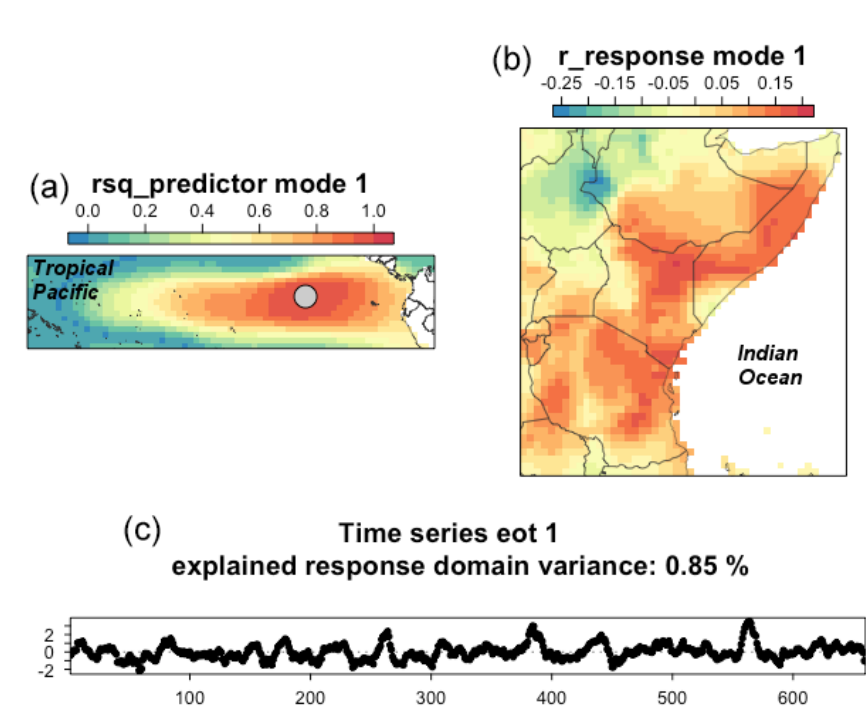
Figure A1. Coupled ocean–atmosphere teleconnection between Pacific sea surface temperatures and eastern African rainfall retrieved from historical observations. (a) The coefficients of determination for the predictor field highlight that the Niño-3.4 region explains the variance in the response domain the most. (b) Correlation coefficients of each pixel of the eastern African (response) domain show that spatially the coastal parts and the north-western area are explained by the predictor field. (c) Time series of tropical Pacific SST anomalies at the base point (the grey circle in a ) of the first mode as an ENSO